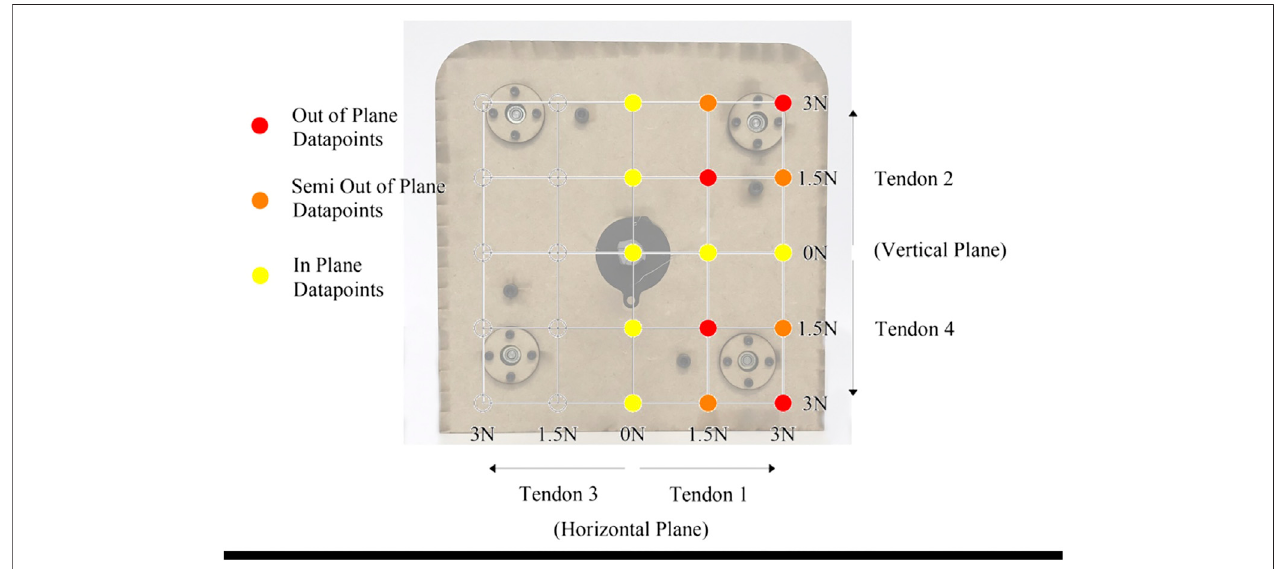
FIGURE 6 | Overlay of experimental tendon tension combinations. Three different regions are de fi ned; In-Plane, Semi-Out-of-Plane and Out-of-Plane data points.